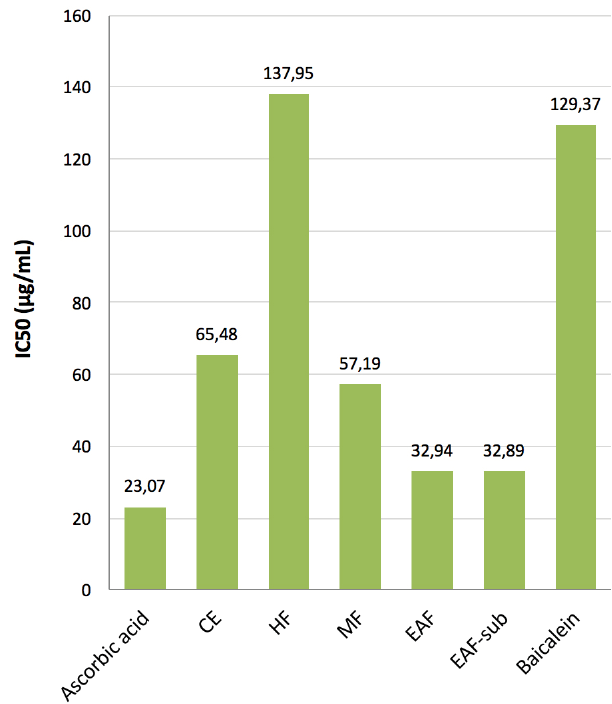
FIGURE 3 - DPPH IC50 (μg/ml) of the crude extract, hexane, methanol and ethyl acetate fractions, subfraction of ethyl acetate fraction, compound (1) and ascorbic